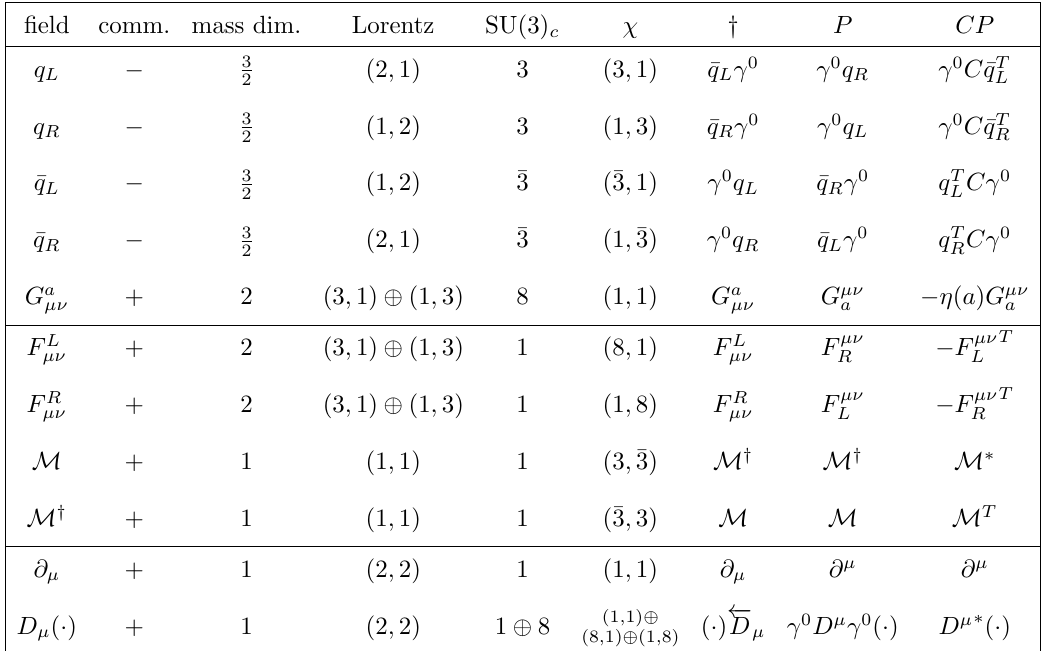
Table 3 . Properties of dynamical (cid:12)elds, spurion and external (cid:12)elds, and derivative operators. For simplicity, additional arbitrary phases in P - and CP -conjugation are neglected. (cid:17) ( a ) is de(cid:12)ned in (A.6). The Lorentz group is locally isomorphic to SU(2) L (cid:2) SU(2) R . together with a charge matrix Q and a coupling e , we only consider operators with at most one QED (cid:12)eld-strength